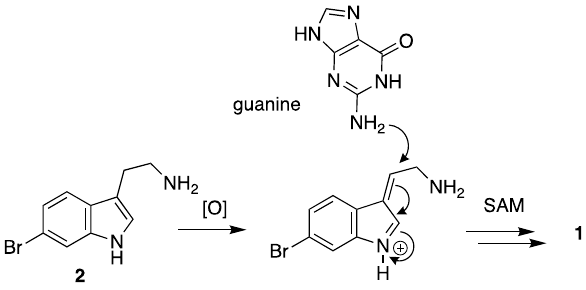
Figure 4. Putative biosynthesis of geobarrettin D ( 1 ).